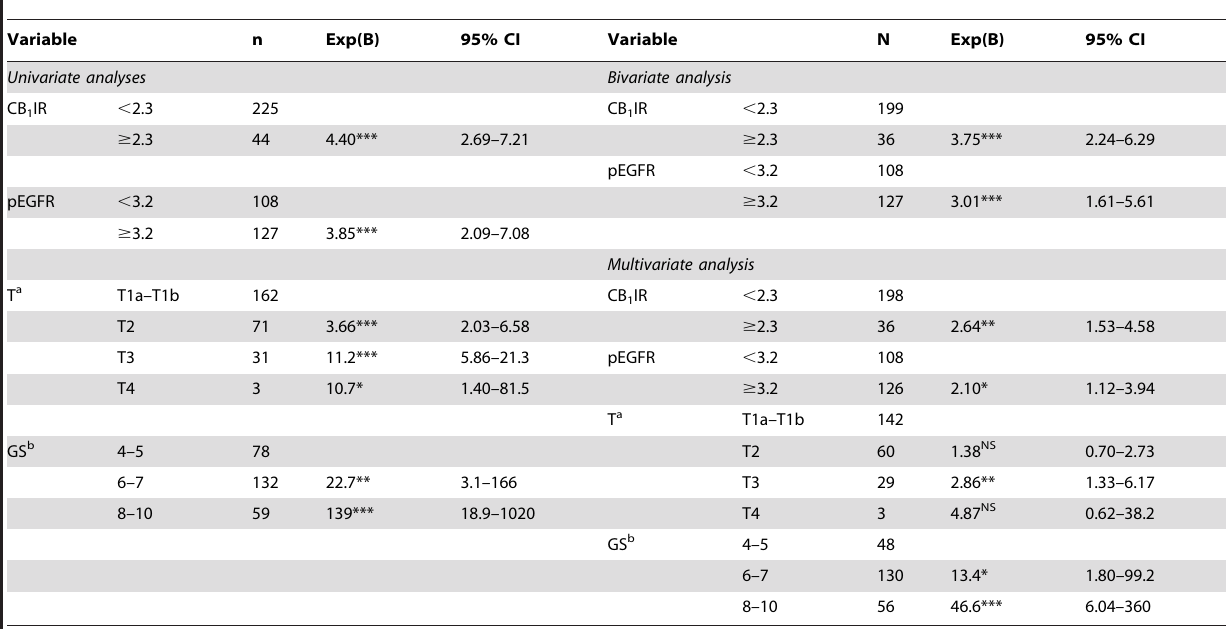
Table 1. Cox proportional-hazards regression analyses for tumour epithelial CB 1 IR and pEGFR-IR scores.